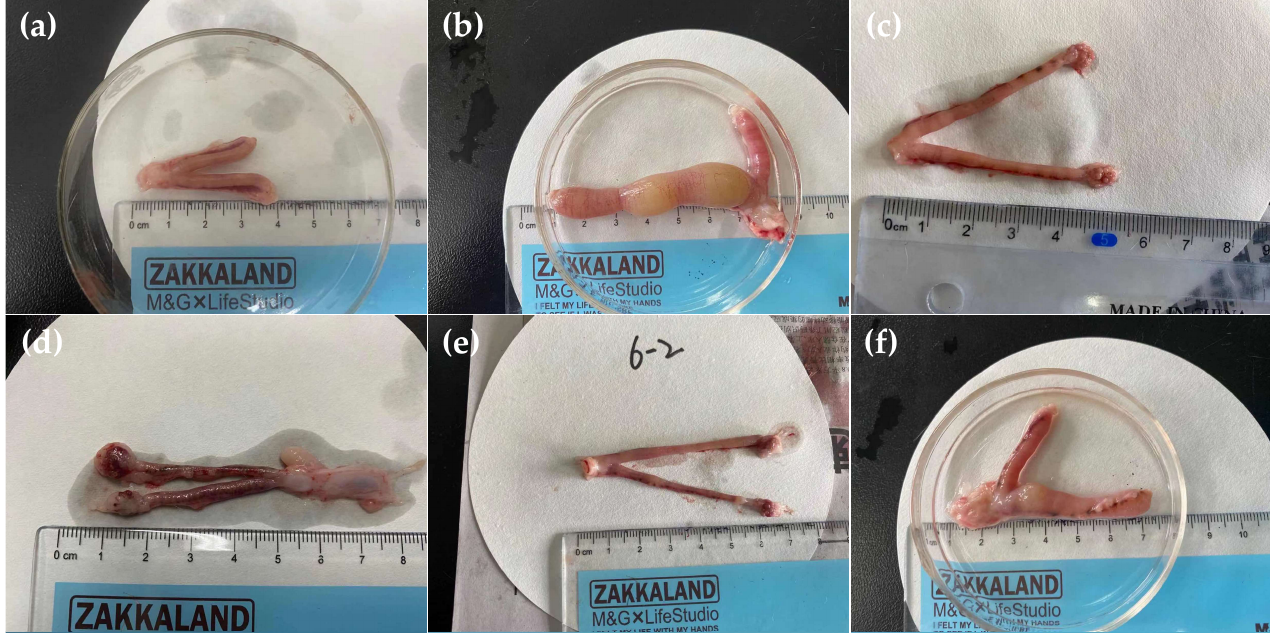
Figure 7. Macroscopic uterus morphology comparison of rats in various groups. ( a ) Control group. ( b ) Endometritis group. ( c ) Ceftiofur group. ( d – f ) Luteolin treatment groups (L, 50 mg/kg b.w; M, 100 mg/kg b.w; H, 150 mg/kg b.w,